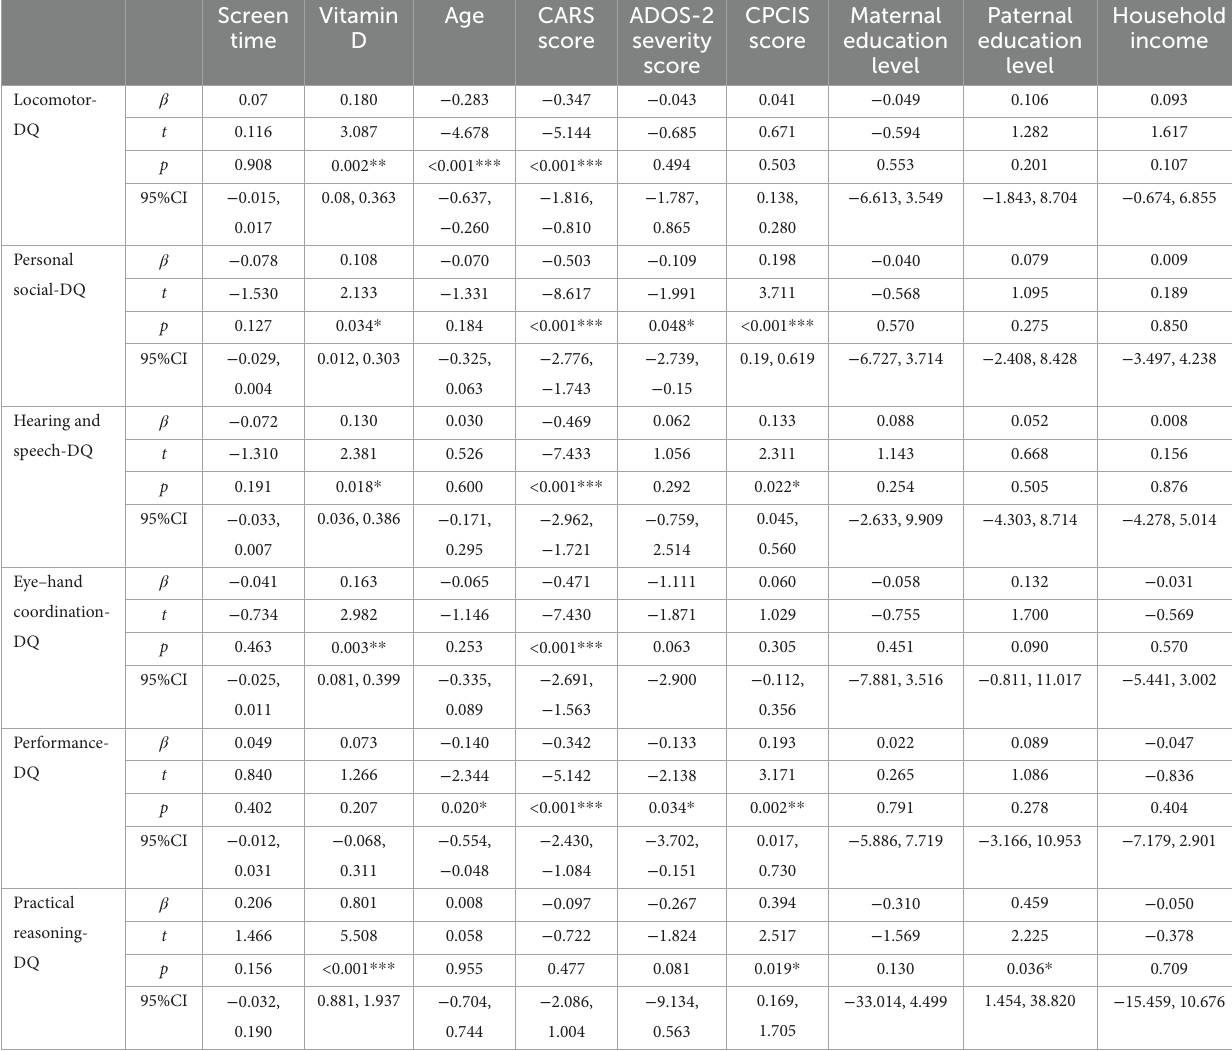
TABLE 4 Multiple linear regression model of DQ scores in children with